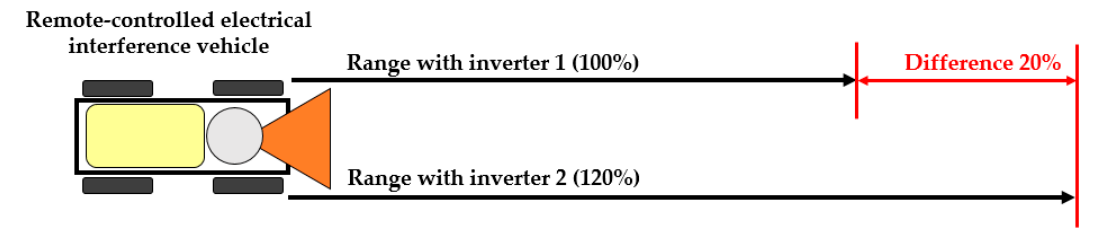
Figure 31. Comparison of ranges with Converter 1 and 2.